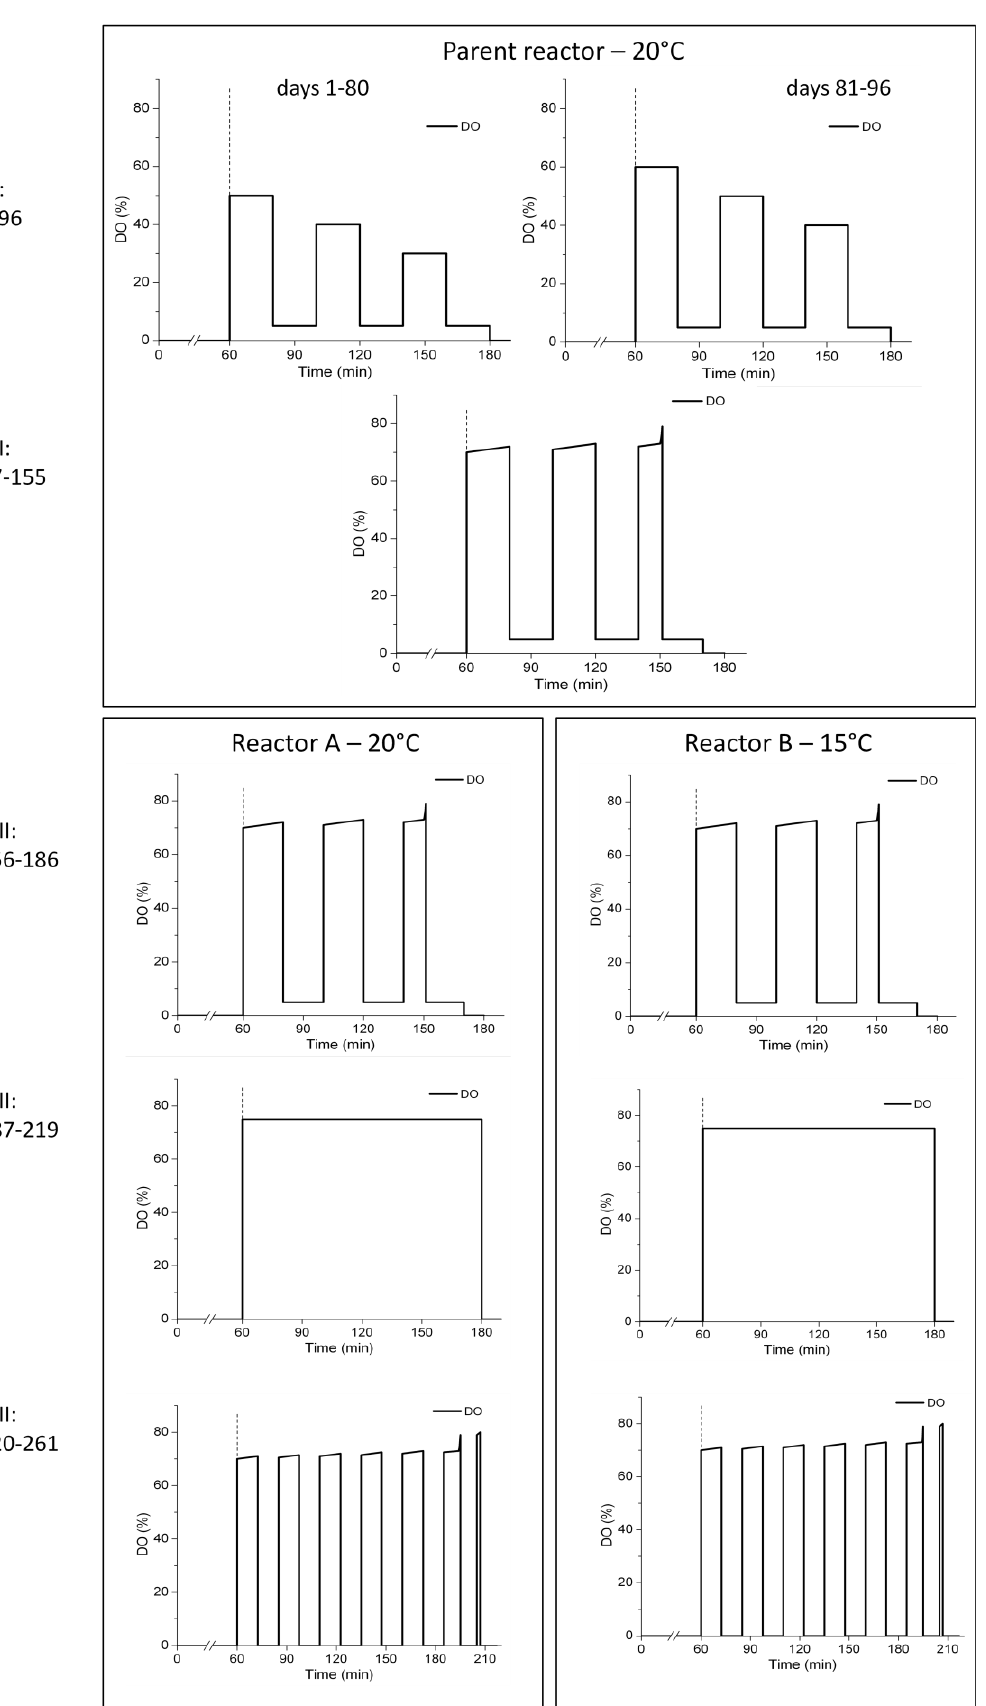
Figure 1. Schematic representation of the aeration strategies during the five experimental